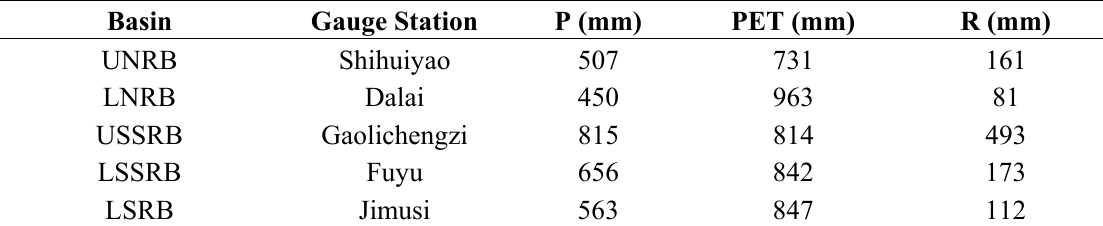
Table 2. Averages of precipitation (P), potential evapotranspiration (PET) and runoff (R) in Upper Nenjiang River Basin (UNRB), Lower Nenjiang River Basin (LNRB), Upper Second Songhua River Basin (USSRB), Lower Second Songhua River Basin (LSSRB), and Lower Songhua River Basin (LSRB), Northeast China.